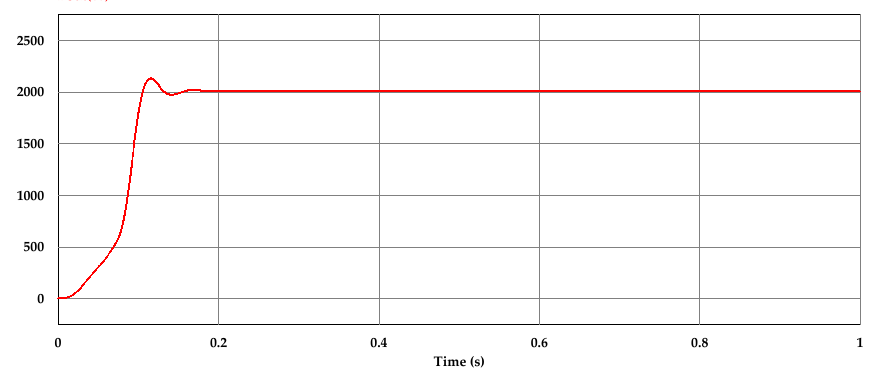
Figure 9. Converter output power curve at full load condition.